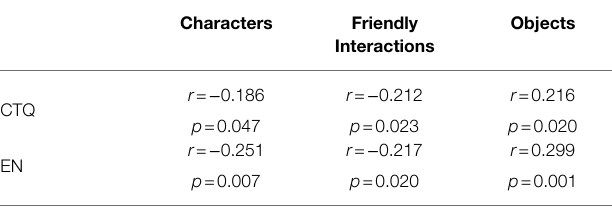
TABLE 3 | Correlations between total childhood trauma and emotional neglect scores and characters, friendly interactions, and objects in the dream content.